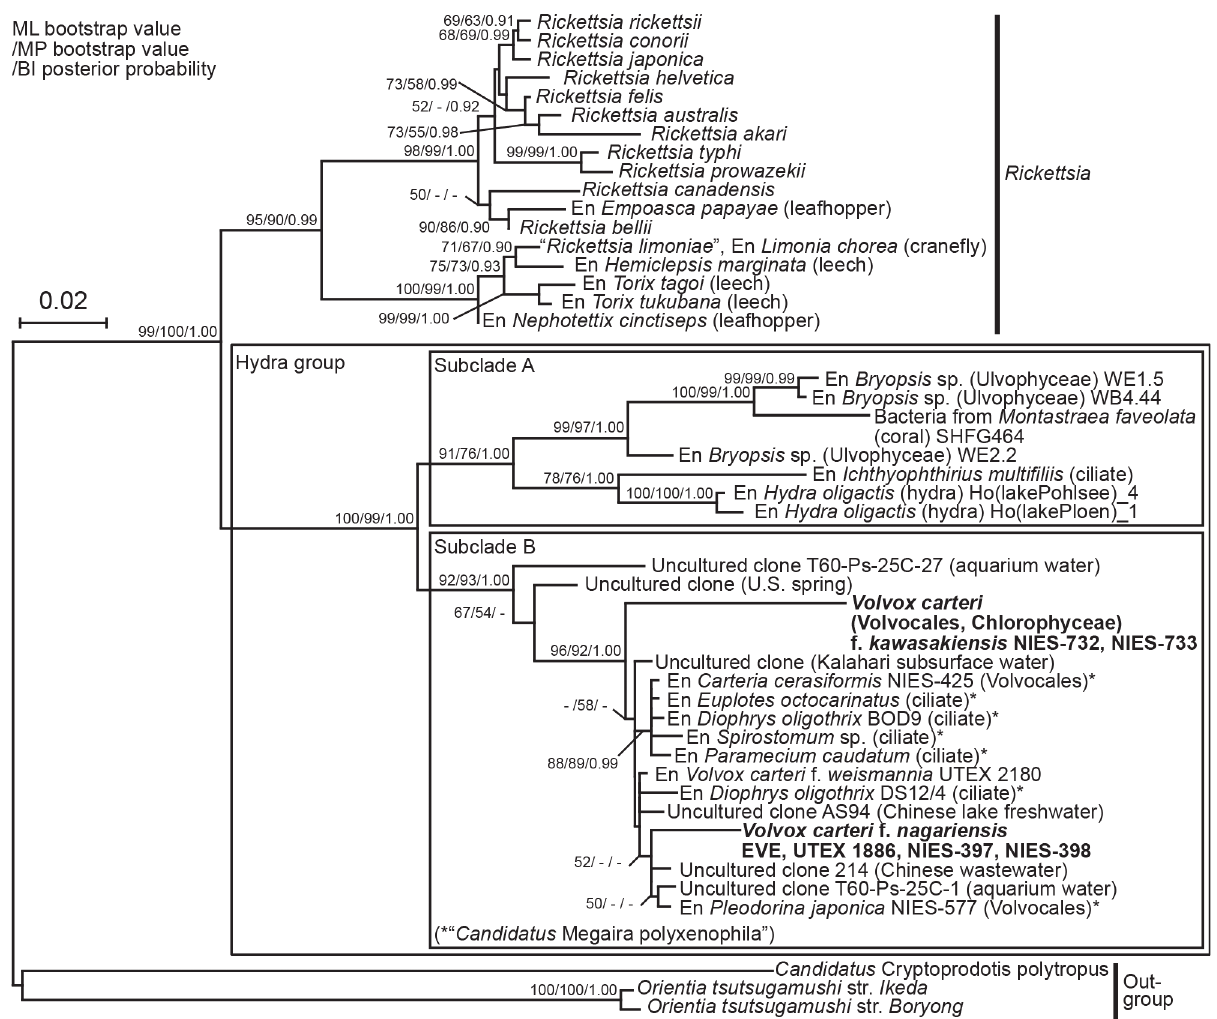
Fig 3. Phylogenetic positions of rickettsial 16S rRNA gene-like sequences in Volvox carteri nuclear genomes. The tree was inferred using the maximum-likelihood (ML) method based on 43 sequences and 1,403 nucleotides of the 16S rRNA genes from bacteria, endosymbionts (En) of eukaryotic hosts, and other environmental samples, of the family Rickettsiaceae , including rickettsial 16S rRNA gene-like sequences obtained from endosymbiont- lacking strains of V . carteri (bold). Bootstrap values ( (cid:2) 50%) for the ML and maximum parsimony analyses, and posterior probabilities ( (cid:2) 0.90) for Bayesian interference, are indicated at the respective nodes. The scale bar corresponds to 0.02 nucleotide substitutions per position. The hydra group and ‘ Candidatus Megaira polyxenophila ’ refer to the organisms studied by Weinert et al. [10] and Schrallhammer et al. [9], respectively.